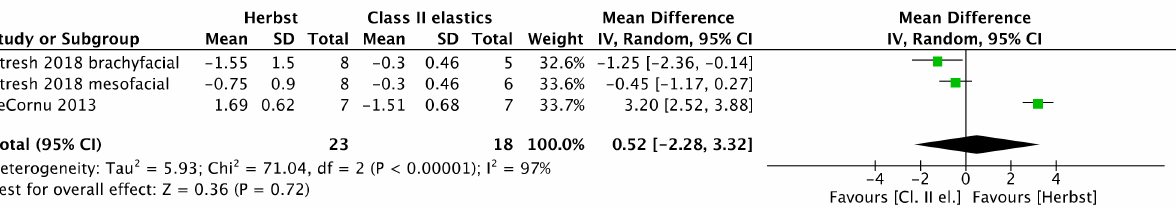
Figure 22. Forest plot of right anterior glenoid fossa anteroposterior changes using the random effects model